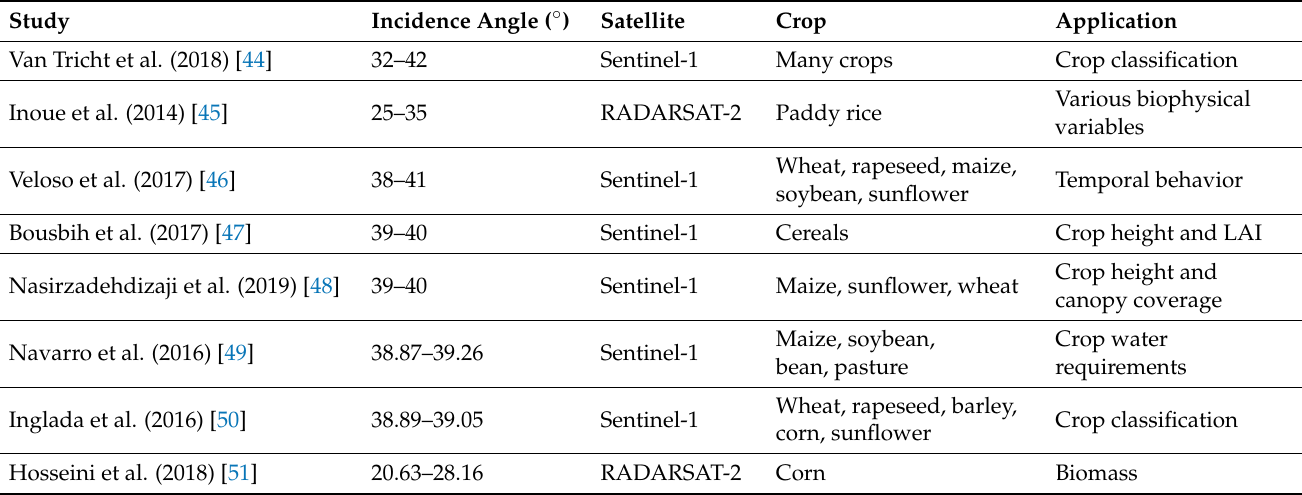
Table 1. Summary of the incidence angle range considered in past